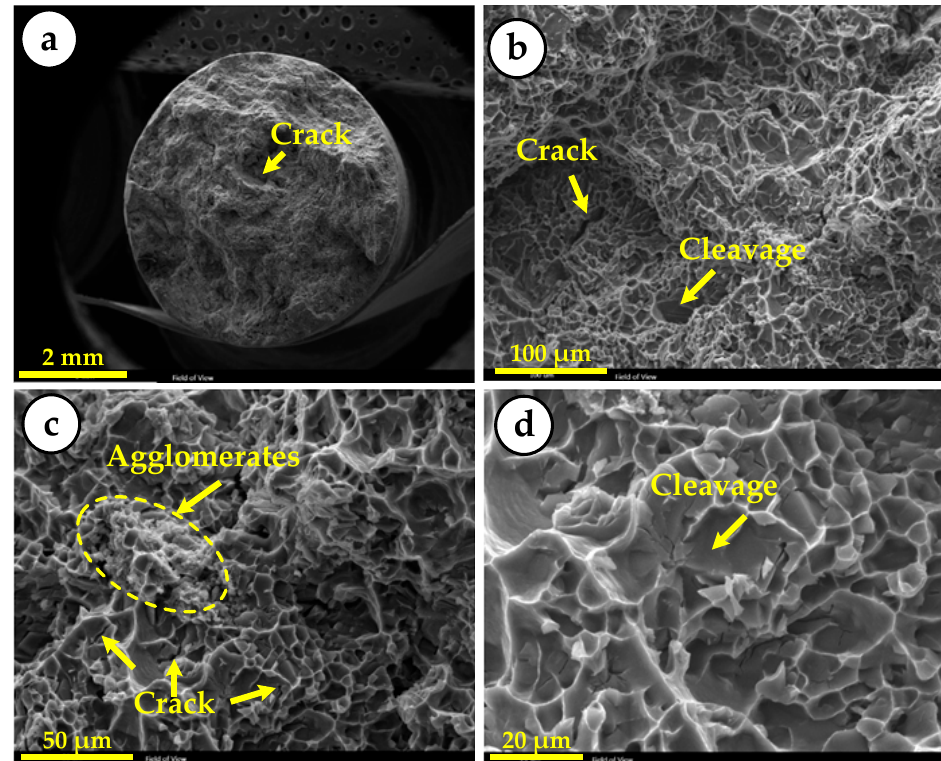
Figure 10. SEM micrographs of the fractured surface of COMP4 ( a ), at different scales of 100 µm ( b ), 50 µm ( c ), and 20 µm ( d ).